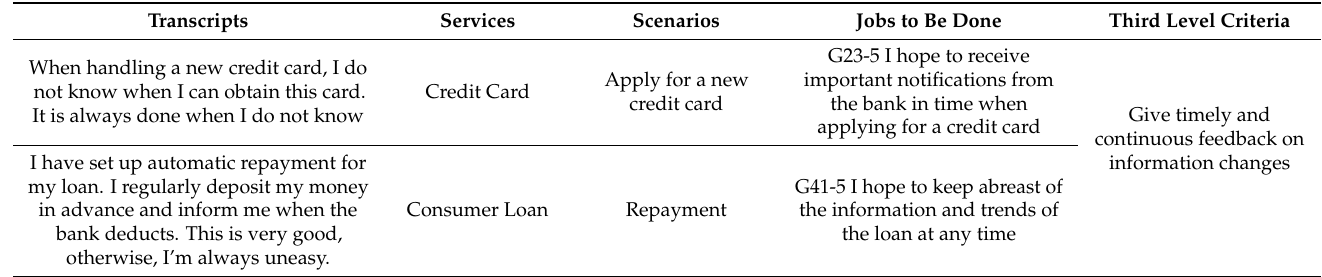
Table 2. Example of integrating the UX criteria from the interview